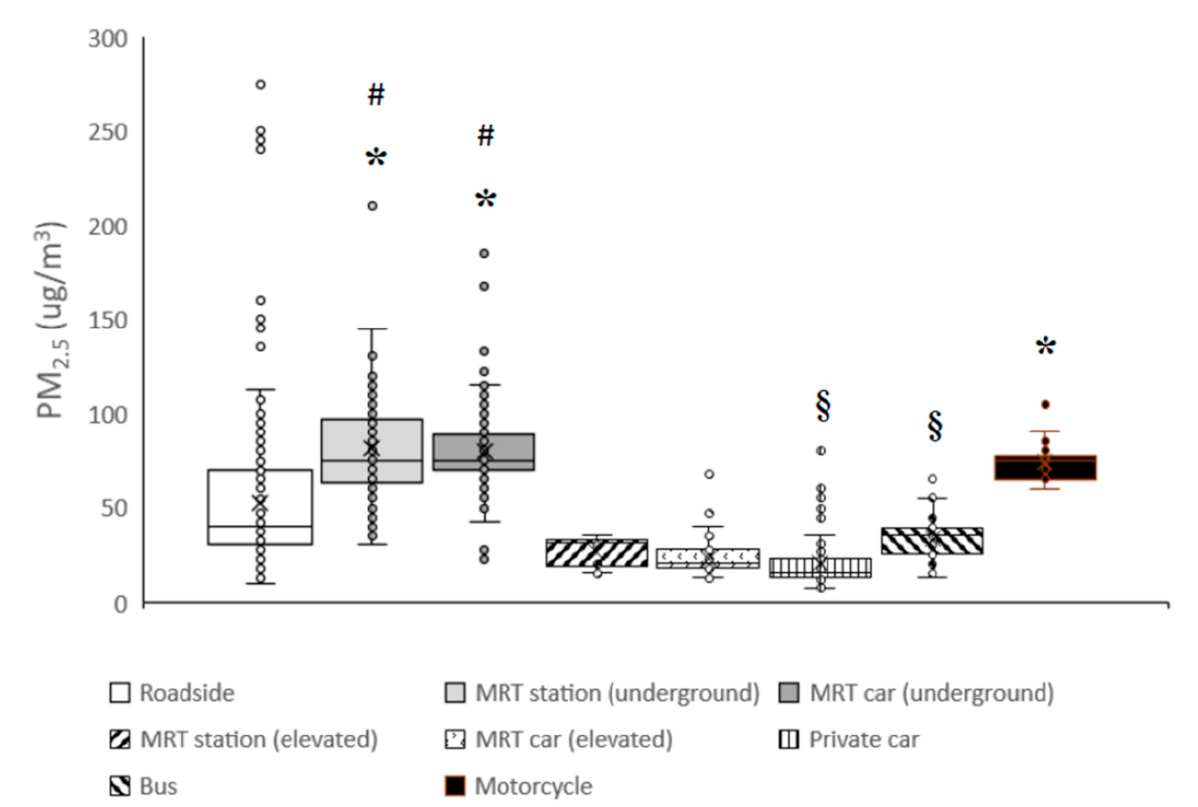
Figure 8. Comparison of PM 2.5 concentrations among different modes of